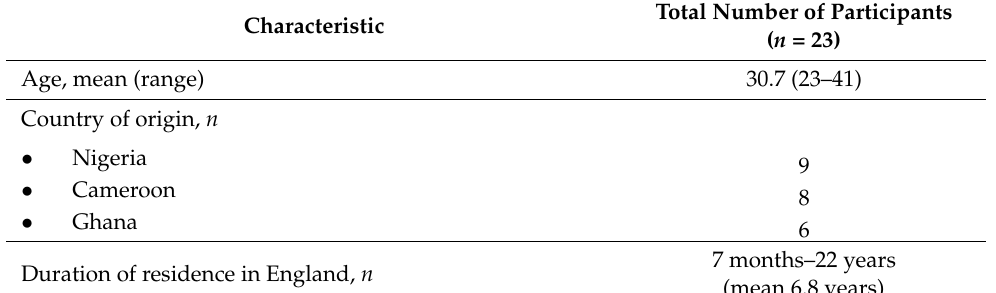
Table 1. Participant